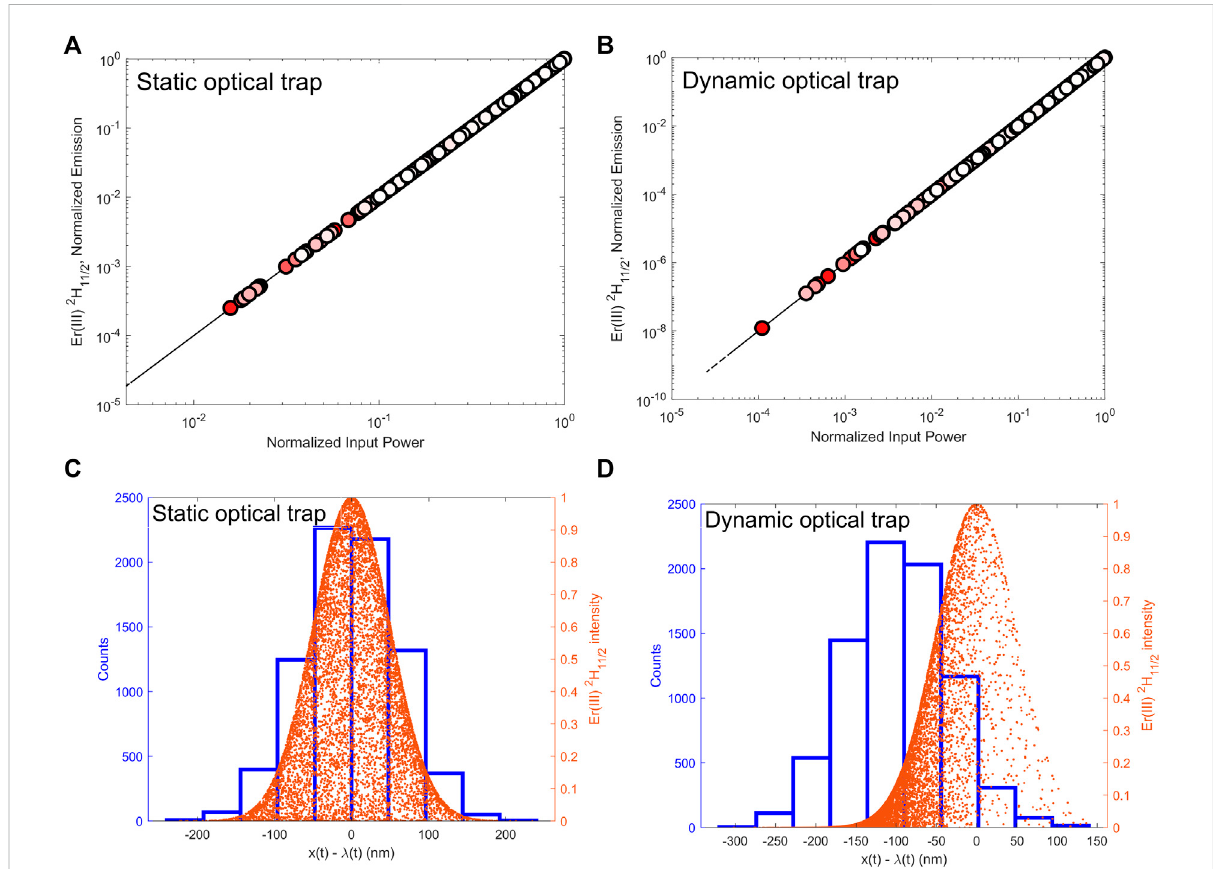
FIGURE 3 Top: On-the- fl y calculation of nonlinear optical power law from individual stochastic trajectories: (A) Static optical trap; (B) Dynamic optical trap with pulling speed υ = 5.5 μ m.s -1 . The color gradient from red to white represents the simulation time (red corresponds to an early time, and whitecorrespondstoalatertime).Bottom:histogramofparticleposition(inblue)andthefullsetofemissionintensities(orangedots)asafunctionof position: (C) Static optical trap. (D) Dynamic optical